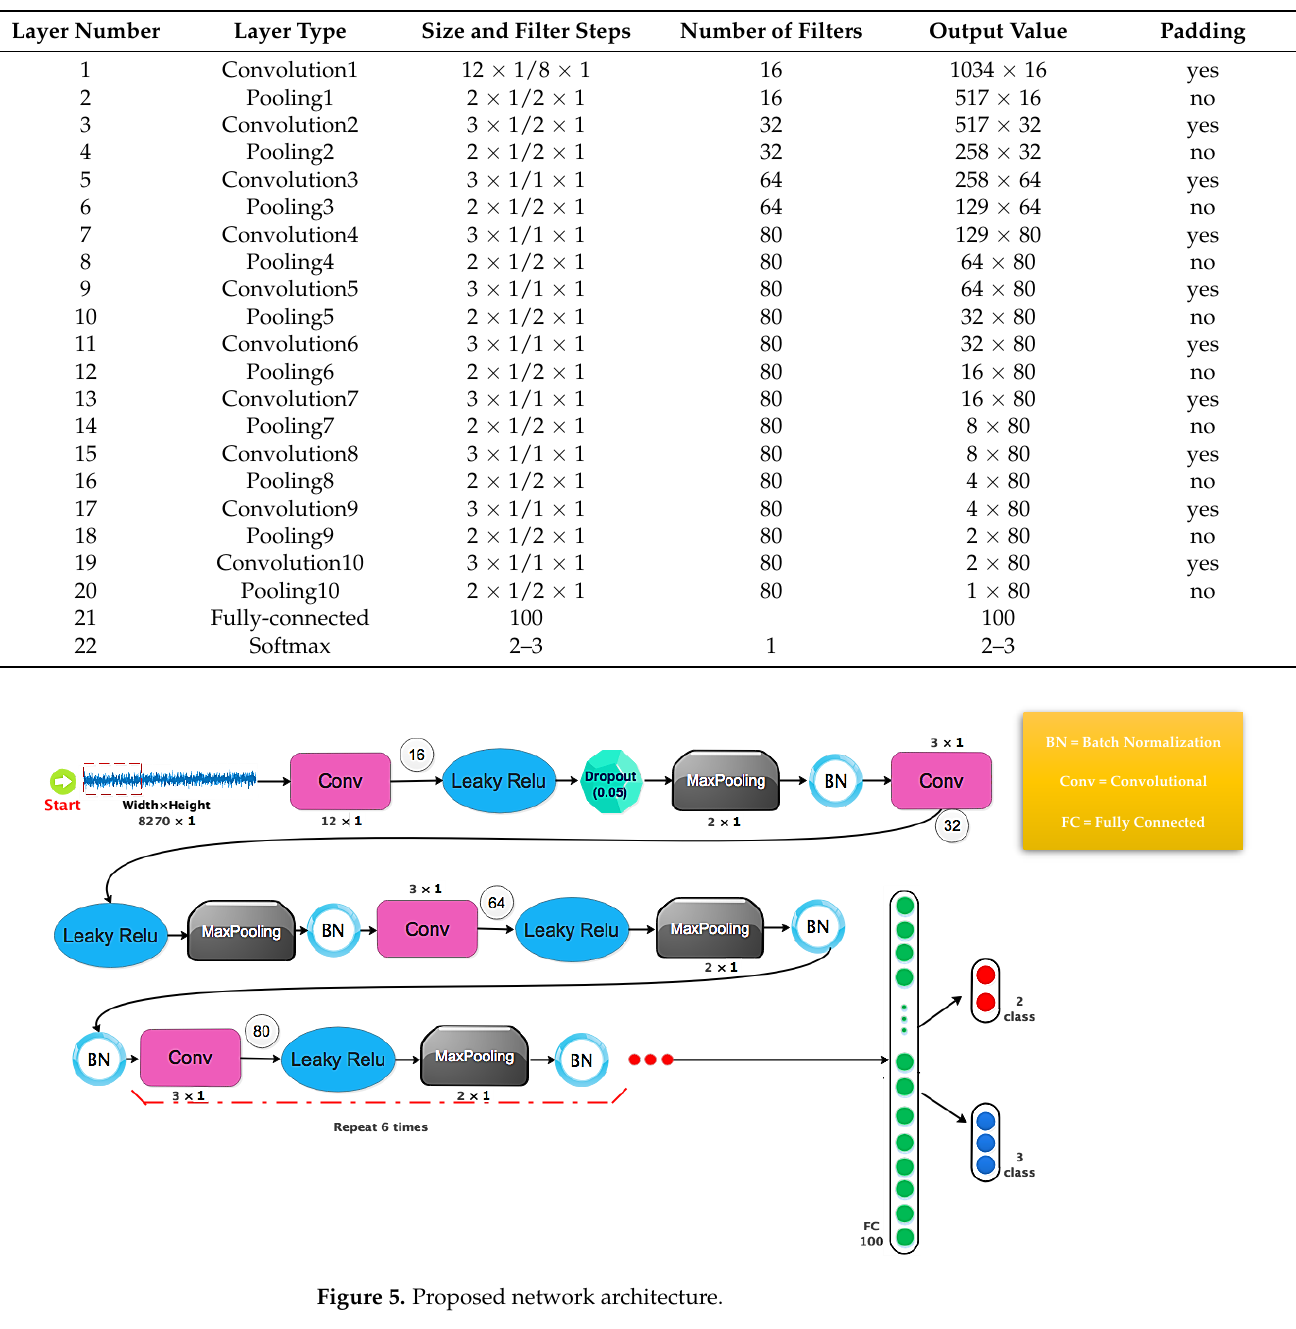
Figure 6. EEG data allocation in the proposed method for two-class and three-class scenario.